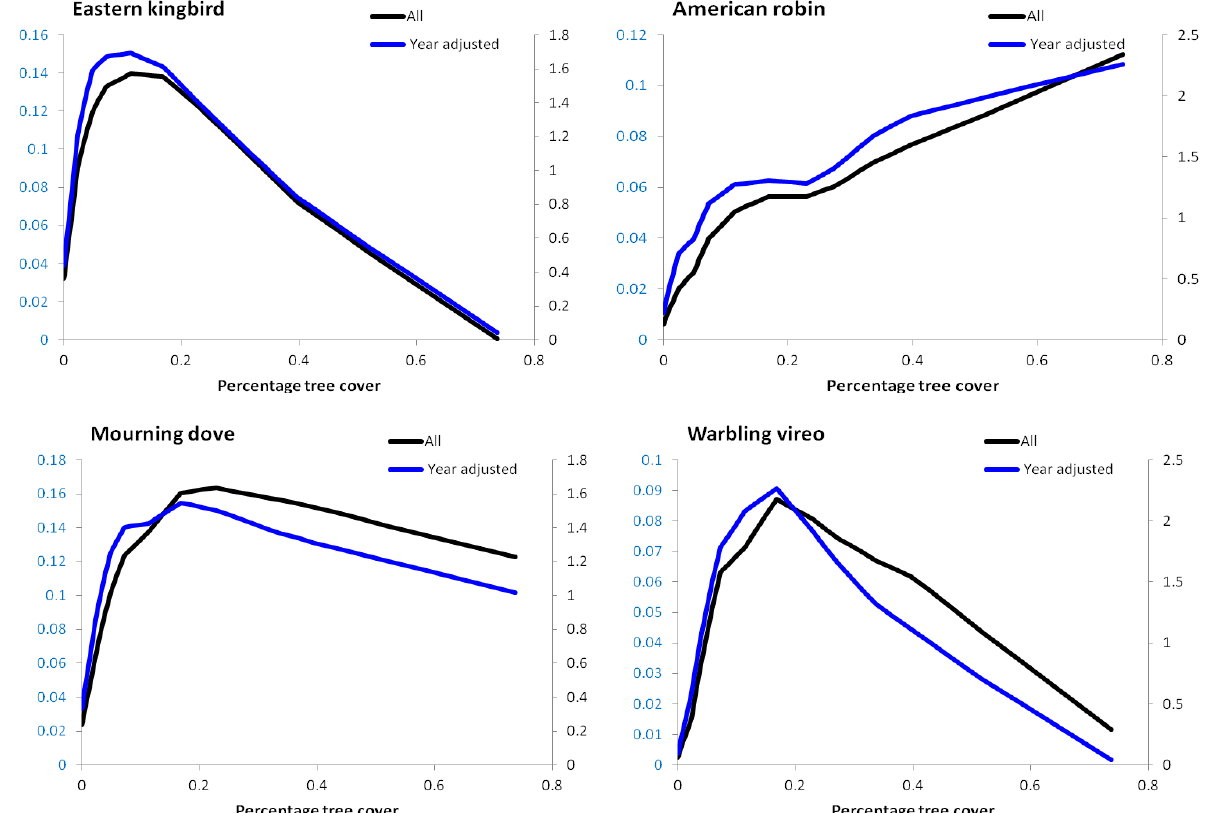
Figure A1.4 Standard (1/0) and year-adjusted results for four species evenly distributed among